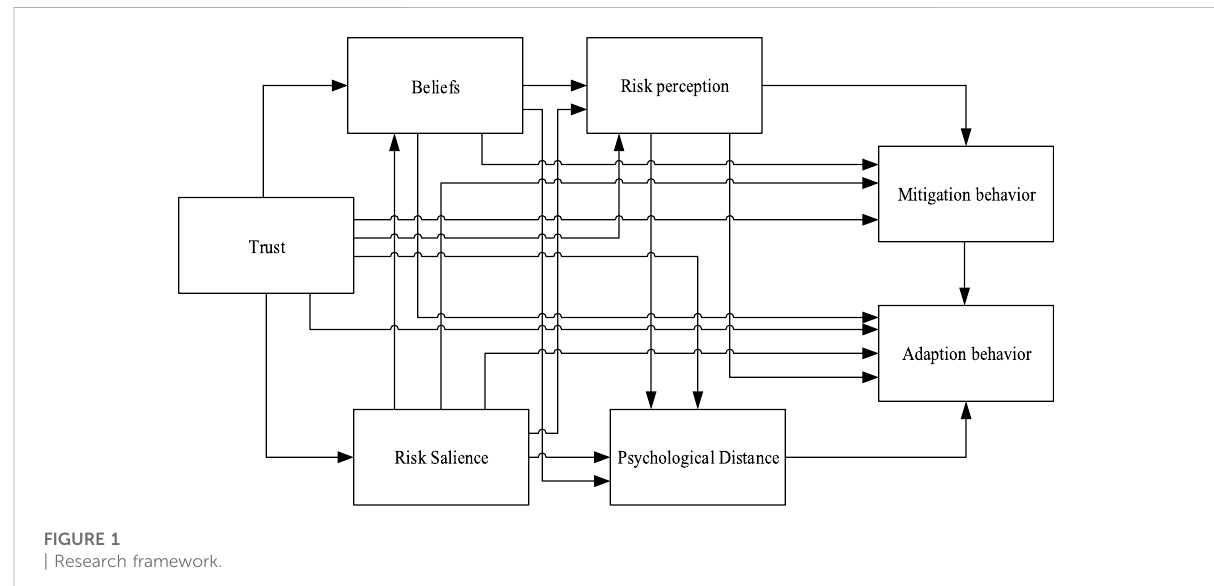
FIGURE 1 | Research